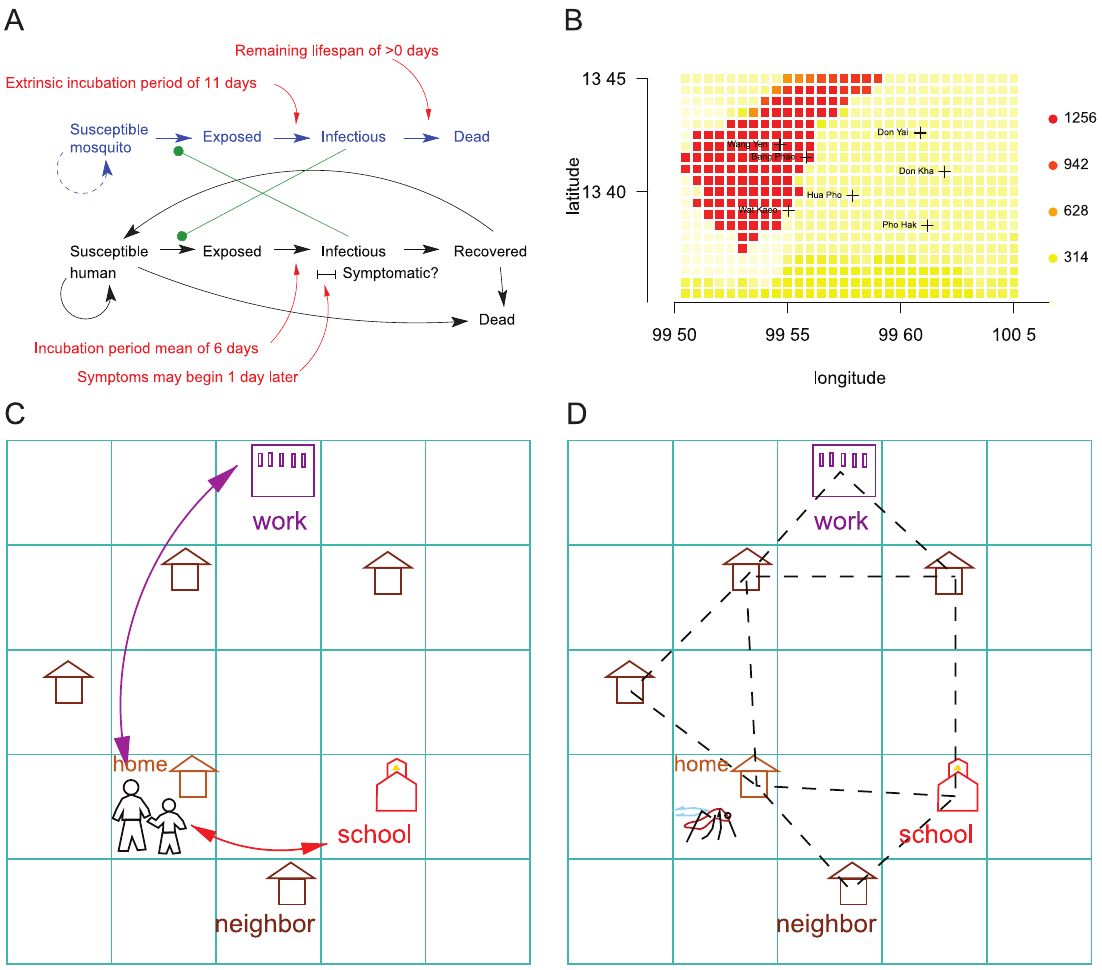
Figure 1. Computer simulation model of dengue transmission. (A) Natural history of dengue model. Susceptible individuals are infected by mosquitoes, and mosquitoes are infected by humans. (B) Population density of the 20 km by 30 km region surrounding Bang Phae, Thailand, at a 1 km 2 resolution. Red indicates high population density, yellow and white for low density, as indicated in the legend in units of people per km 2 . Population density data is from GRUMP [28]. (C) Movement of humans in the model. People start and end the day at home, and go to work or school during the day. (D) Movement of mosquitoes in the model. Aedes aegypti are associated with a single building. Each day, they may migrate to an adjacent location (e.g., house, school, temple), as indicated by the dashed lines, with a probability of 15% and to a random location with a probability of 1%.